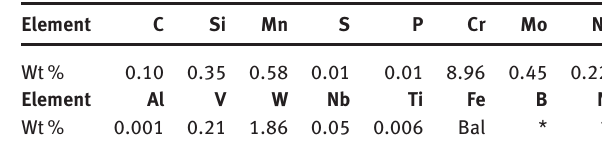
Table 1: Chemical composition of T92 steel.